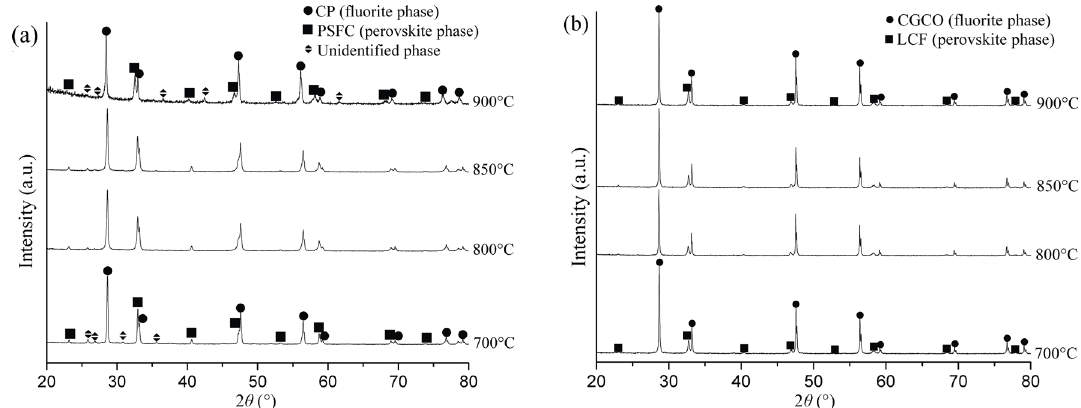
Fig. 4 XRD patterns of (a) 50CP–50PSFC and (b) 75CGCO–25LCF supports after exposure to a rich CO 2 atmosphere at different temperatures during 20